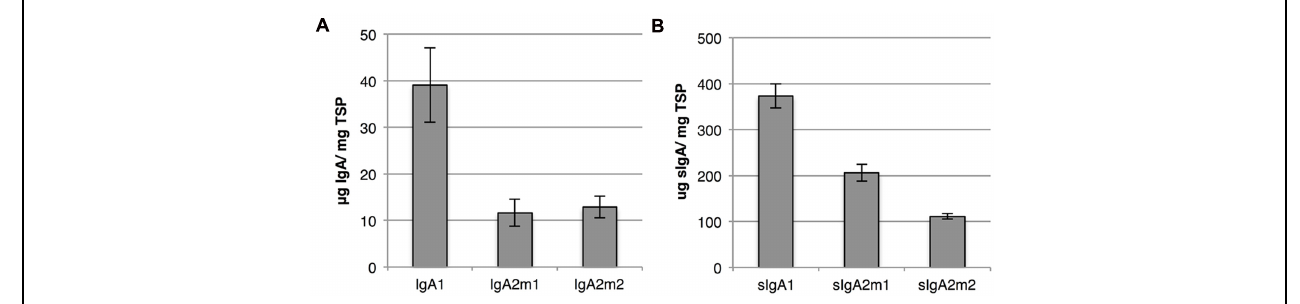
FIGURE 6 | IgA and sIgA yield using multi-cassette expression vectors. (A) Average IgA yield of three biological replicates upon expression of IgA1, IgA2m1, and IgA2m2 using multi-cassette vectors harvested 6 dpi. IgA yield in leaf extracts was determined by sandwich ELISA using a kappa chain specific capture and alpha heavy chain specific detection antibody. Error bars indicate standard error. (B) Average sIgA yield of three biological replicates upon expression of sIgA1, sIgA2m1, and sIgA2m2 using multi-cassette vectors (vector system 1 in Figure 3B ) and harvested 6 dpi. sIgA yield in leaf extracts was determined by sandwich ELISA using a kappa chain specific capture and secretory component specific detection antibody. Error bars indicate standard error.